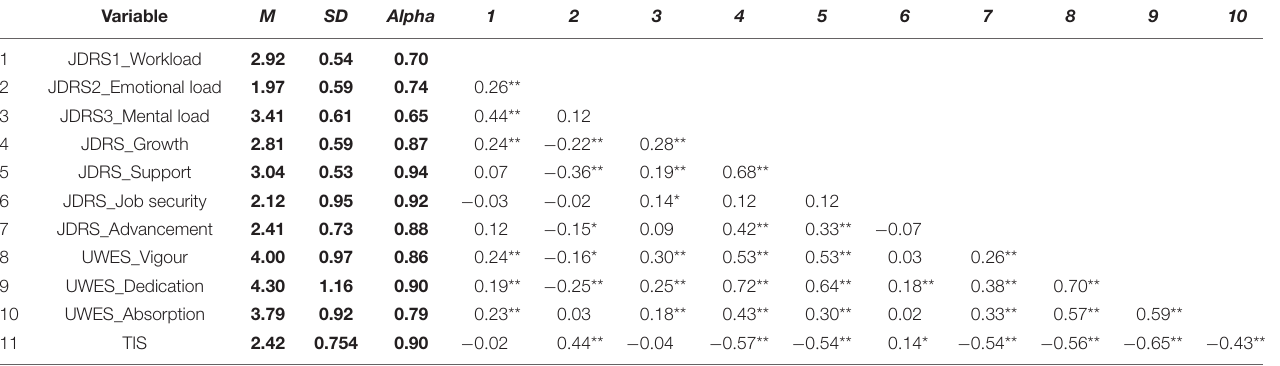
TABLE 2 | Means, standard deviations, Cronbach’s alpha values, and correlations between factors. Variable